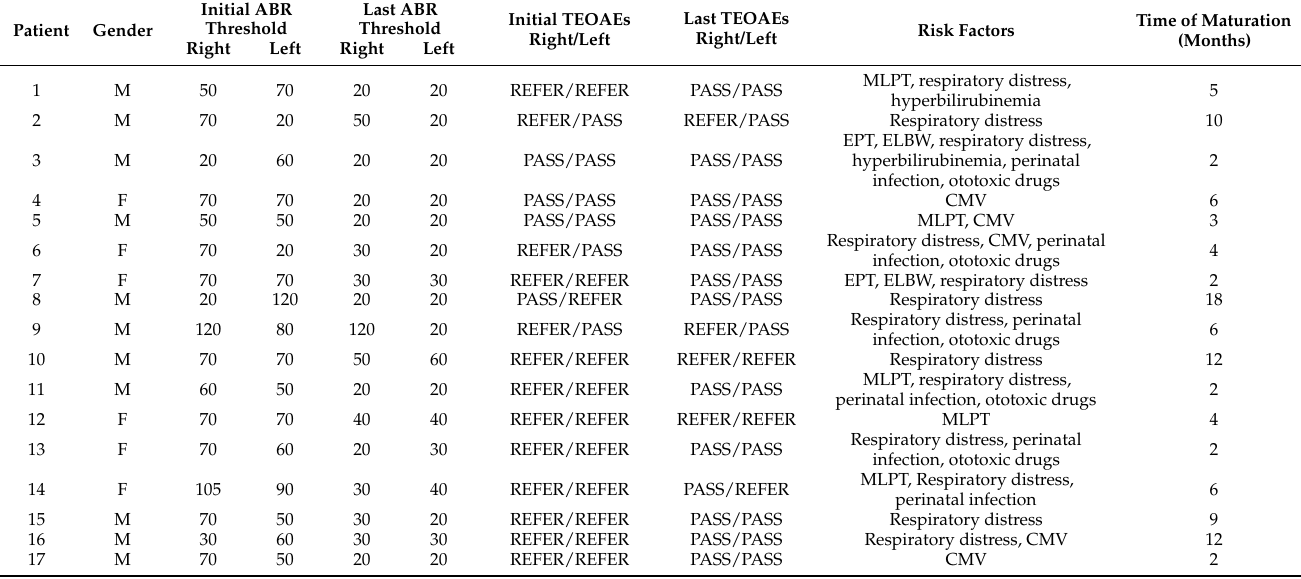
Table 3. Audiological findings in patients with observed maturation of auditory